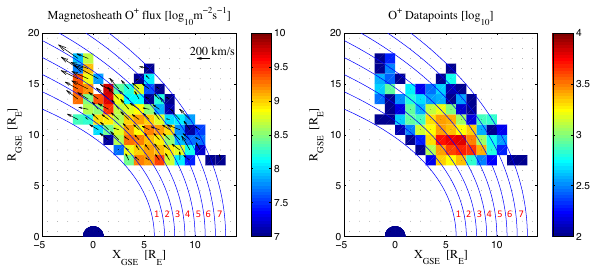
Fig. 2. (A) Average flux, (B) magnetosheath O + occurrence rate, Fig. 2. A) Average flux, B) magnetosheath O + occurrence rate, and C) O + escape flux (Average flux times occurrence rate), as functions of outward distance, with segment 1 and 7 corresponding to the innermost and and (C) O + escape flux (average flux times occurrence rate), as outermostsegmentrespectively. functions of outward distance, with Segment 1 and 7 corresponding to the innermost and outermost segment respectively. is the one closest to Earth. The binning of the data is theupperrightcornerofthefiguredefinesthelengthcorrespondingto 200 km/s. Eachsquarebinis 115 netosheathofthatbin. Theoccurrencerateofeachbinisdefinedasthenumberofdatapointswhere O + isobservedinthemagnetosheathdividedbythetotalnumberofdatapoints. Theoccurrencerate 120 is needed to calculate the total O + escape flux in the magnetosheath. This will be further discussed below. Figure 1 (right) gives an overview of the spatial distribution of the O + magnetosheath data set, which contains a total of nearly 100 . 000 datapoints. The majority of the measurements is ob- tainedinaregionwhereeachbintypicallycontainsafewthousanddatapointsandwheremostofthe considered spacecraft trajectories are. The rest of the bins (where magnetosheath O + is observed) 125 containafewhundreddatapointseach,sufficientforastatisticalanalysis. ThebluelinesinFig.1aretheoreticalmagnetopauses(Shueetal.(1997)),usedtodividethemag- netosheath data set into spatial segments, numbered 1 to 7, such that segment 1 is the one closest to Earth. The binning of the data is made with no consideration to an actual distance to the mag- 5